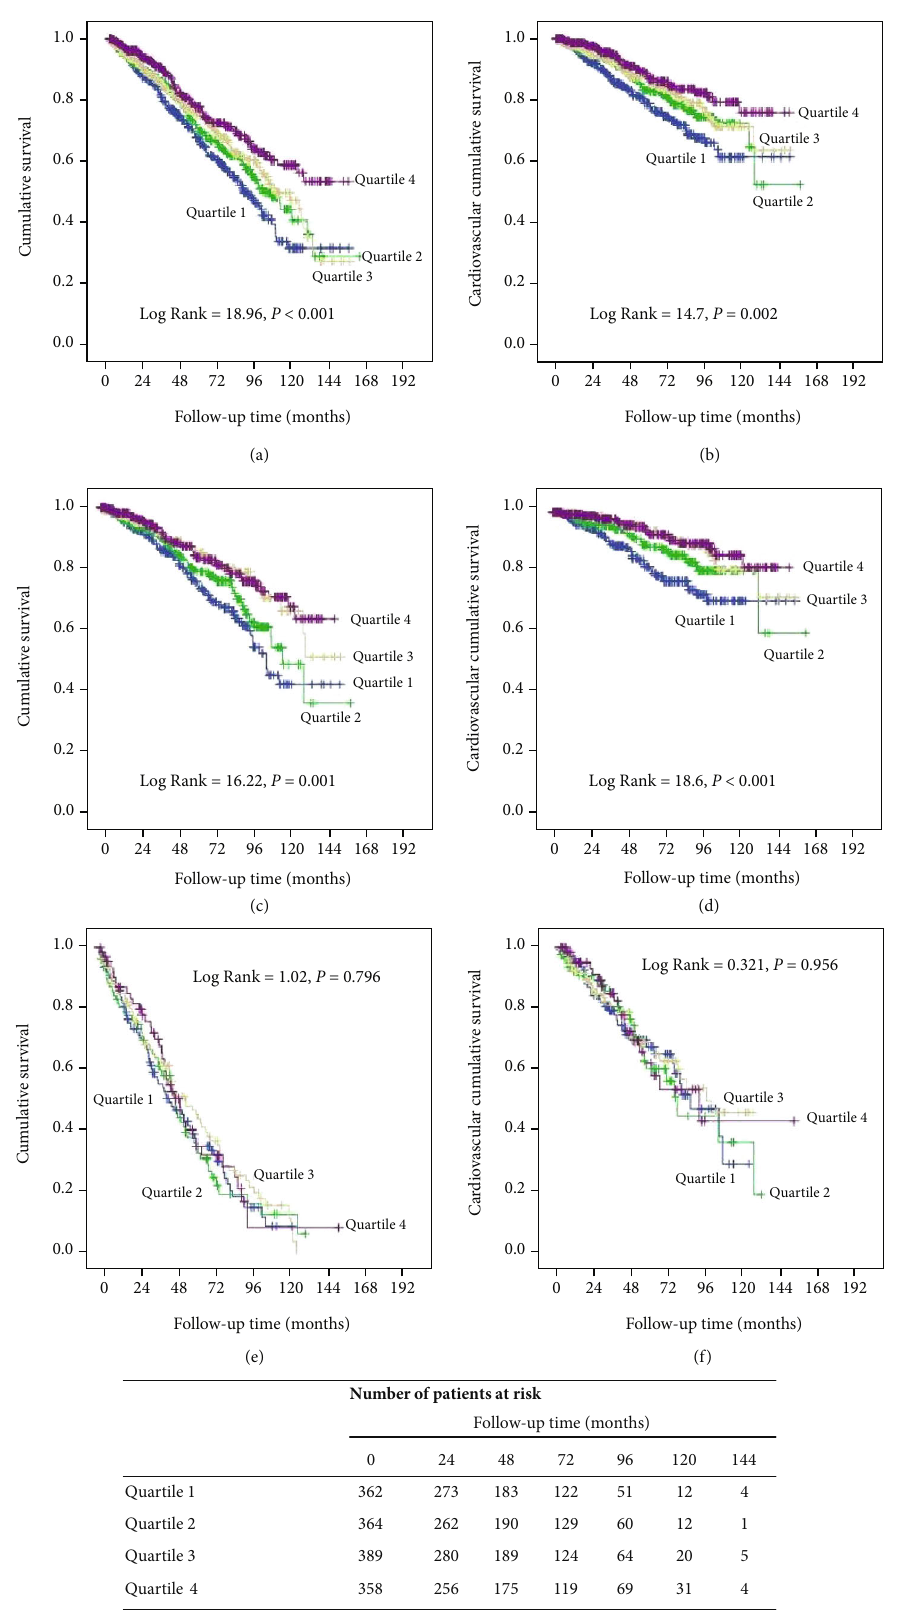
Figure 2: Kaplan-Meier survival curves for patients with di ff erent levels of MPV/PC and strati fi ed by age. Cumulative survival curves for (a, b) overall population, (c, d) age < 60 years, and (e, f) age ≥ 60